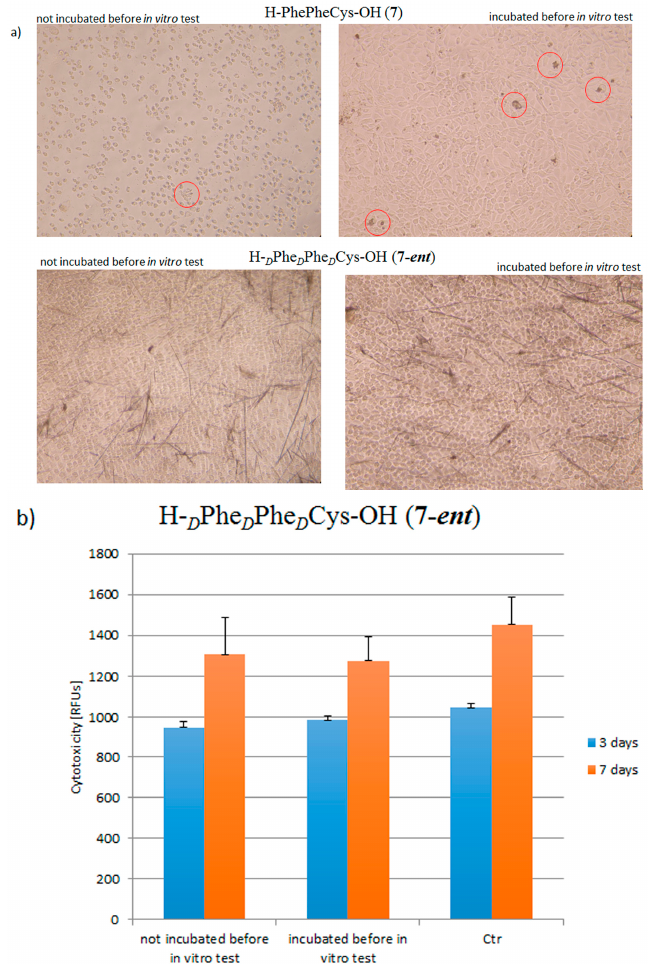
Figure 8. ( a ) Microscopic examination of murine L919 fibroblast cells incubated in the presence of pre-aggregated and aggregating peptides 7 and 7- ent . Images taken on the fourth day of incubation; ( b ) results of PrestoBlue assay evaluating the vitality of L919 fibroblast cells incubated in the presence of peptide materials formed by the 7- ent peptide (RFUs—Relative Fluorescence Units).